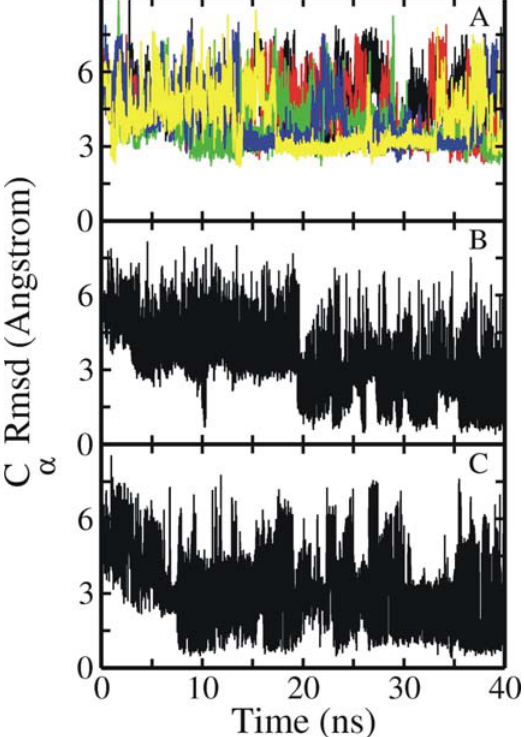
Figure 1. Root-mean-square deviation (Rmsd of C α -atoms) of sampled Trp-Cage conformations from the native structure (1 st entry of pdb1L2Y) vs. simulation time. (A) Rmsd of five independent cMD simulations starting from an extended Trp-cage structure with different initial atomic velocities. (B) Rmsd of conformations sampled during the T- RexMD started from the same extended conformation (for the reference replica run). (C) same as in (B) but for the BP-RexMD (for the replica run with the original force